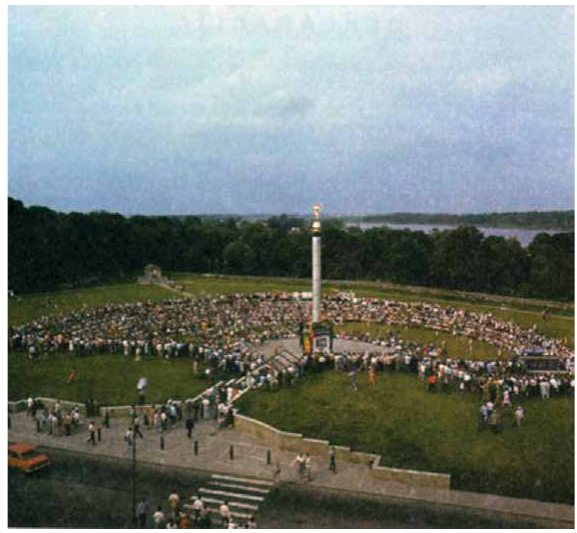
fig. 1. The first meeting of Sąjūdis , 2 july 1988, the Sundial Square in